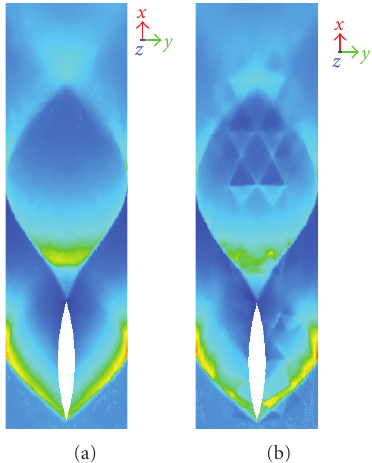
Figure 15: Details of the solution in proximity of the blade and downstream, viewed from underneath—(a) with projection, (b) without.